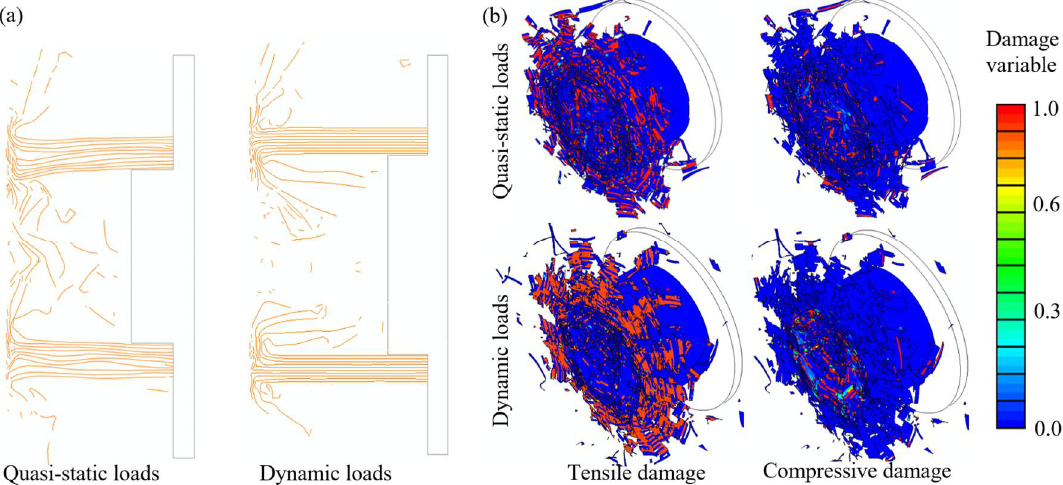
Figure 14. Failure modes of composite tubes after axial crushing tests: ( a ) cross-sectional view (each line refers to a shell layer) and ( b ) distribution of tensile and compressive damage variables.